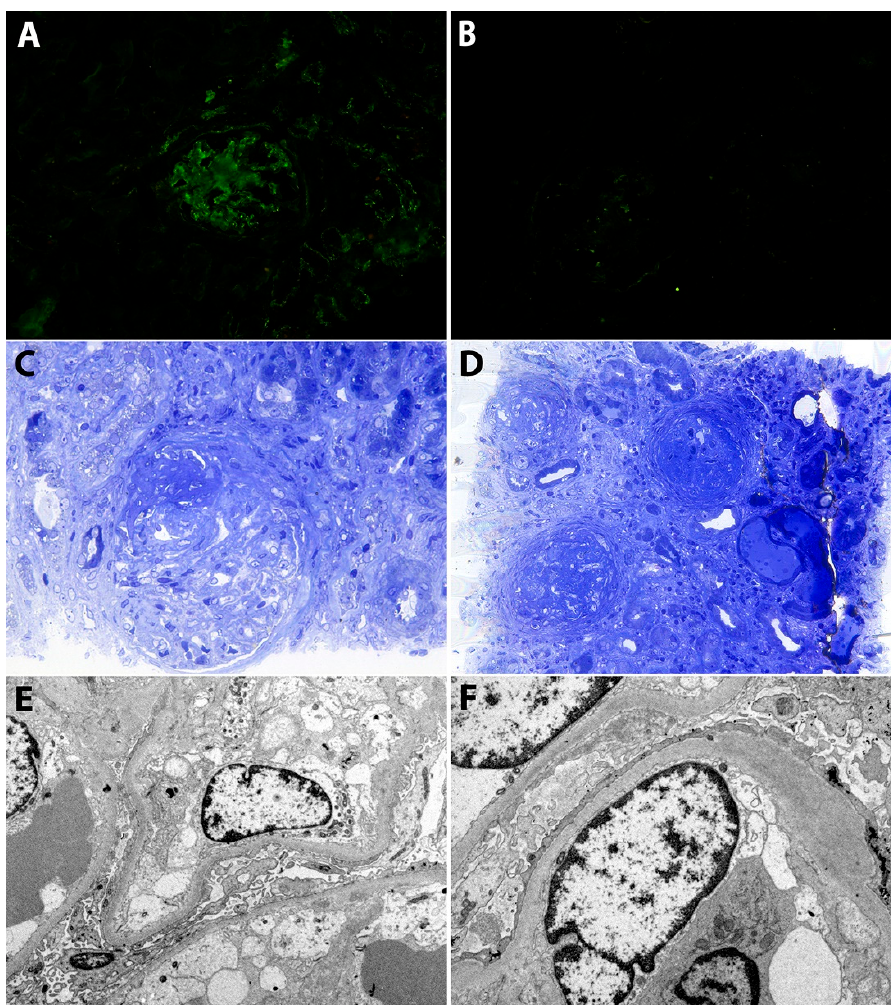
Figure 1. ( A ) Immunofluorescence. Moderate staining for IgG in the mesangium and along the glomerular capillary walls. ( B ) Immunofluorescence. Minimal staining for C3 in the mesangium and along the glomerular capillary walls. ( C ) Light microscopy (Toluidin Blue). Glomerulus with a membranoproliferative pattern of injury, fibrinoid necrosis and a fibro-cellular crescent. ( D ) Light microscopy (Toluidin Blue). Glomeruli showing a membranoproliferative pattern with diffuse lobular accentuation (mesangial expansion with hypercellularity, endocapillary hypercellularity and fibrous crescents). There is also moderate tubular atrophy and interstitial fibrosis. ( E , F ) Electron microscopy. There are subendothelial, unstructured, electron-dense deposits. Podocytes show diffuse foot process effacement. Additionally, there is severe endothelial injury with swollen glomerular endothelial cells and loss of fenestrations.